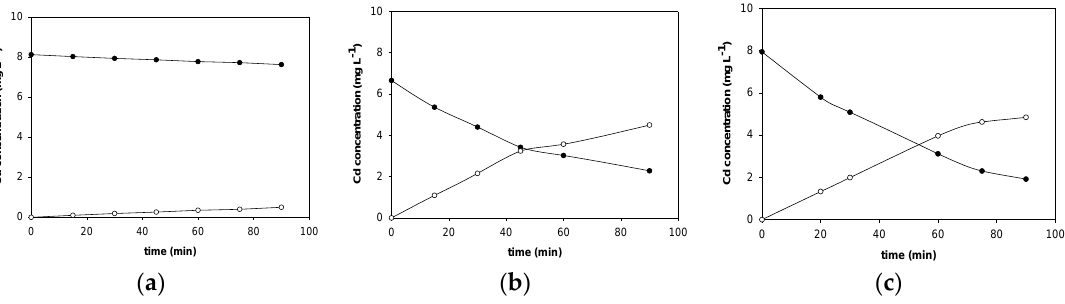
Figure 2. Transient concentration curves in Cd(II) transport experiments involving Trilaurylamine chloride (TLAHCl) ( a ); Tri- n -octylamine TNOA ( b ) and Aliquat 336 ( c ). Closed circles: feed phase; open circles: stripping phase.